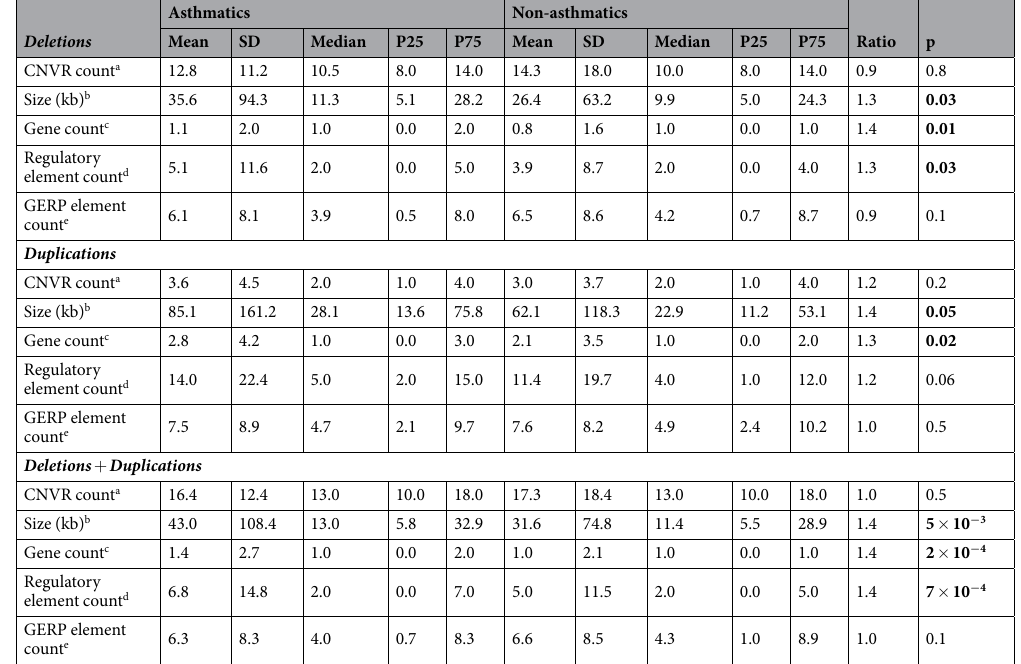
Table 2. Global contribution of copy number variation regions (CNVRs) on asthma outcome. Asthmatic and non-asthmatic children from Salvador-SCAALA were compared in terms of: a count of CNVRs per individual; b estimated size of CNVRs (kb, kilobase); c number of genes captured by CNVR; d number of regulatory elements captured by CNVR; e number of GERP constrained elements captured by CNVR. SD: standard deviation; P25: 25% percentile; P75: 75% percentile; Ratio: case/ctrl ratio (mean); p values ≤ 0.05 were considered statistically significant [Mann-Whitney U test (two-sided)].